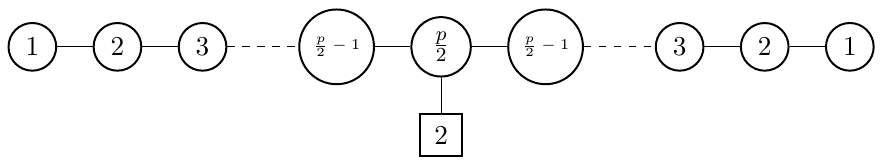
Figure 3 . The Kronheimer-Nakajima quiver associated to a ’t Hooft loop labelled by B = ( p= 2 ; (cid:0) p= 2) (with p even) in the sector v = (0 ; 0) in an N = 2 (cid:3) SU(2) theory.